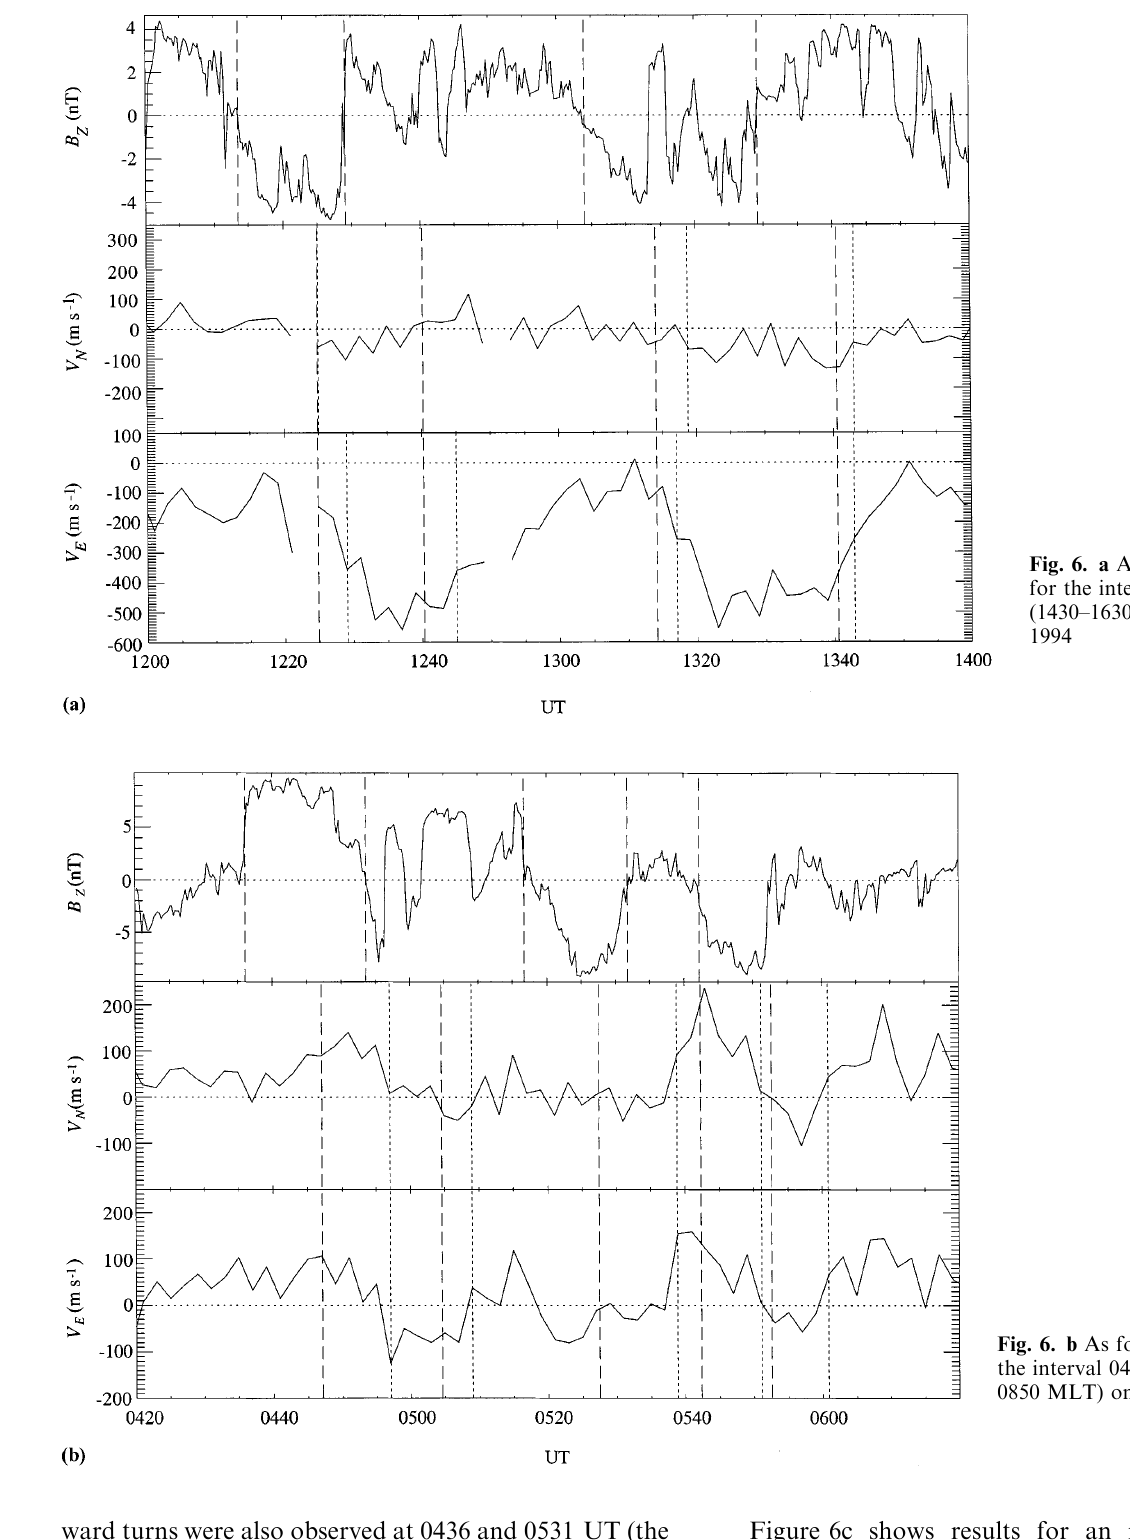
Fig. 6. a As for Fig. 2, except for the interval 1200–1400